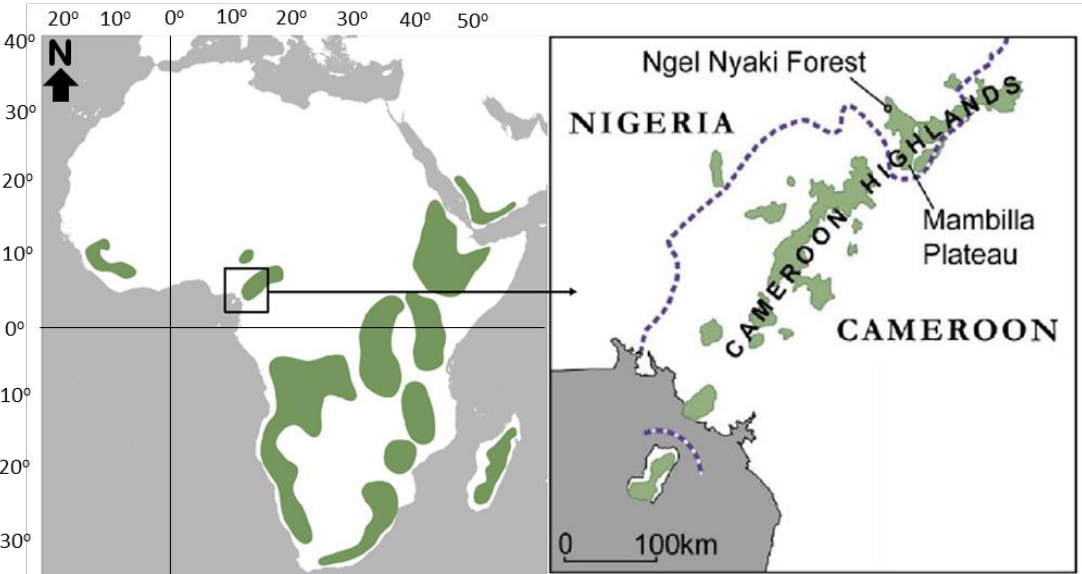
Figure 1. Location of the Ngel Nyaki Forest, on the Mambilla Plateau, Nigeria relative to the approximate distribution of other major montane ecosystems in Africa, shown in green [31]. The forest lies close to the Nigeria/Cameroon border, represented by a dashed purple line.